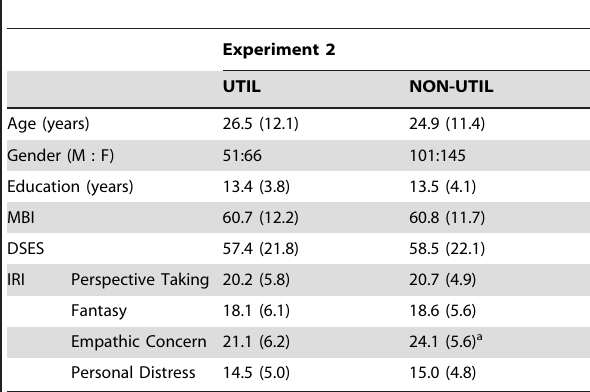
Table 4. Mean ( SD ) values for demographic variables